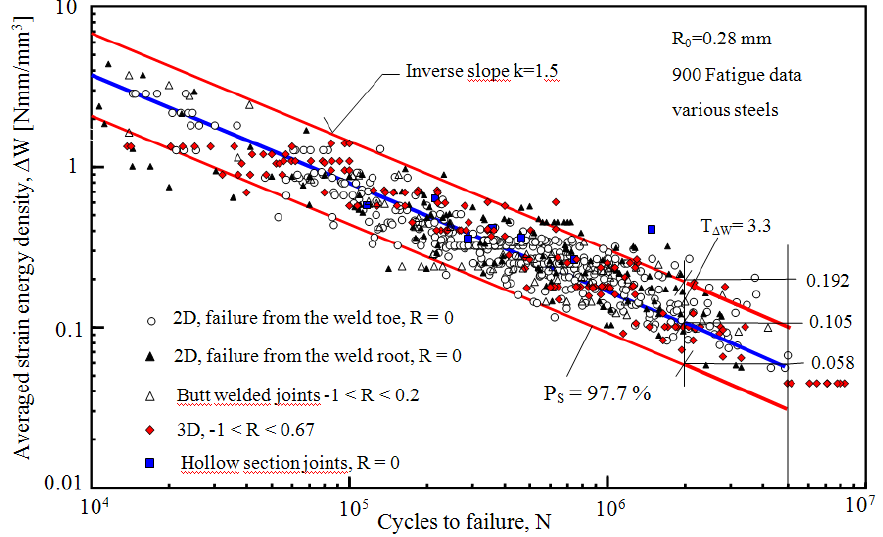
Figura 3: Resistenza a fatica di giunti saldati in acciaio in funzione del valore medio della densità di energia di deformazione [19]; banda di dispersione definita da valore medio  2 deviazioni standard [11]; piatti principali di spessore t variabile tra 6 e 100 mm; piatti trasversali di spessore variabile tra 3 e 220 mm; rotture innescate in corrispondenza del piede o della radice dei cordoni di